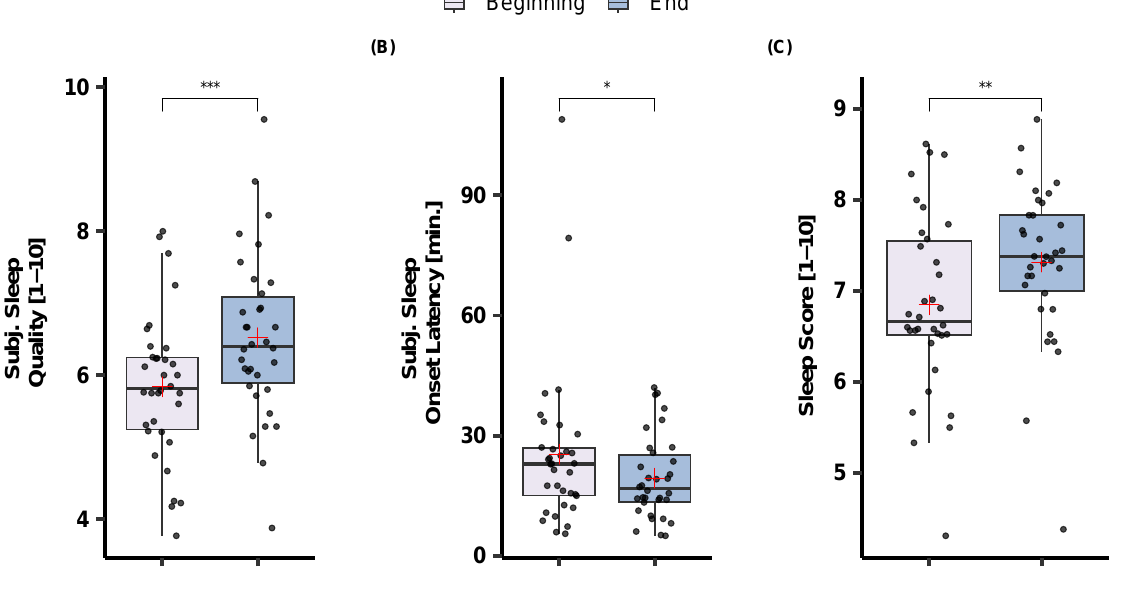
Figure 6. The effects of sleep training on ( A ) sleep quality, ( B ) sleep onset latency, as well as ( C ) sleep score. Sleep score is a mixture of subjective and objective measures (see Methods). Note that participants reported better sleep and shorter sleep onset latency at the end of the sleep training program. p < 0.05 *, p < 0.01 **, and p < 0.001